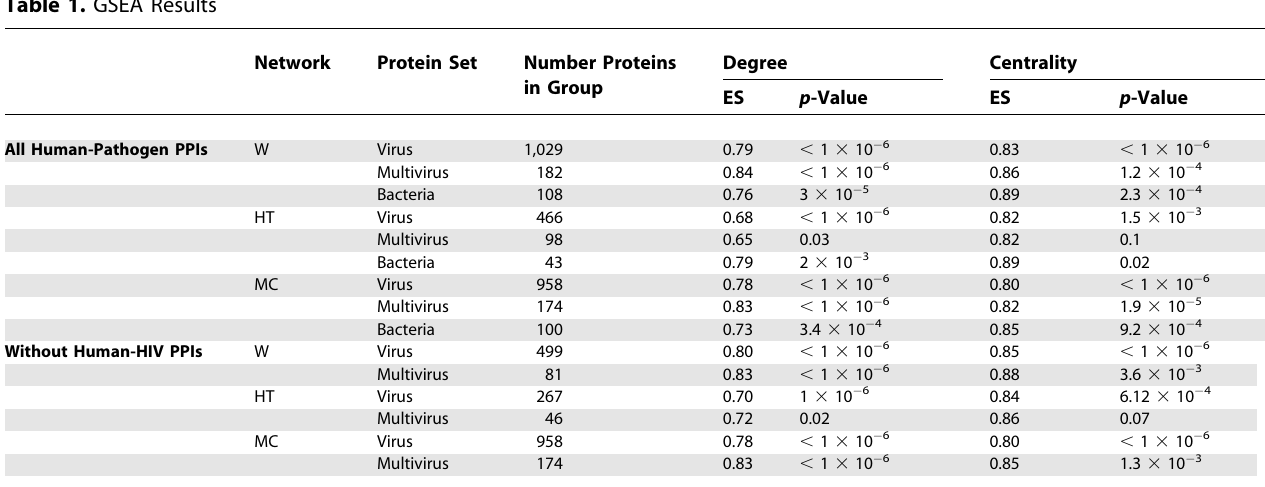
Table 1. GSEA Results